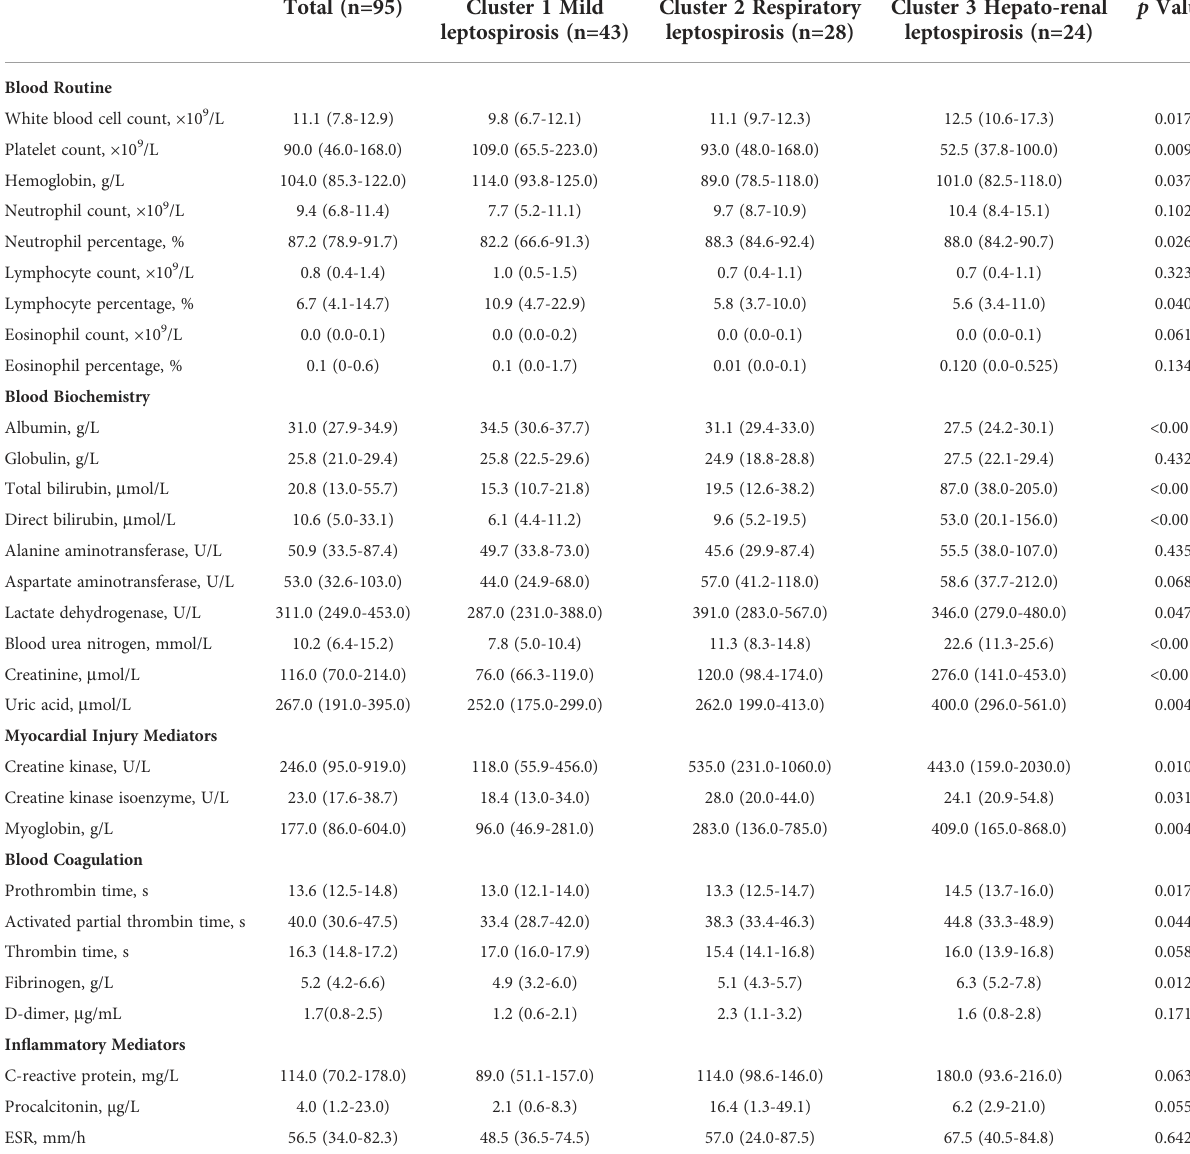
TABLE 2 Laboratory fi ndings of different clusters. Total (n=95) Cluster 1 Mild leptospirosis